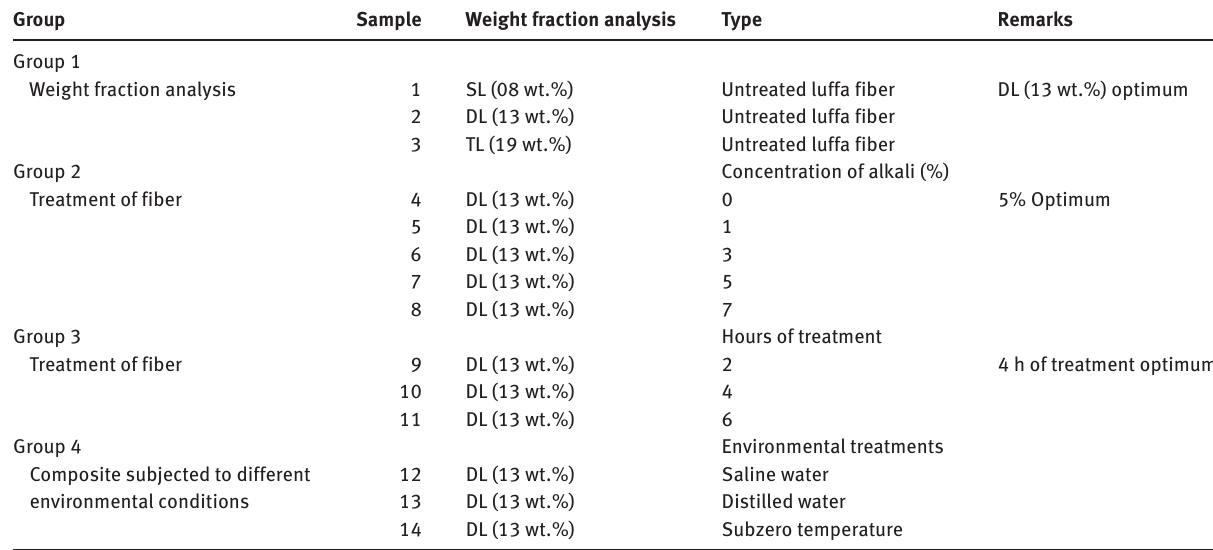
Table 1: Types of luffa fiber used for the preparation of composites. Group